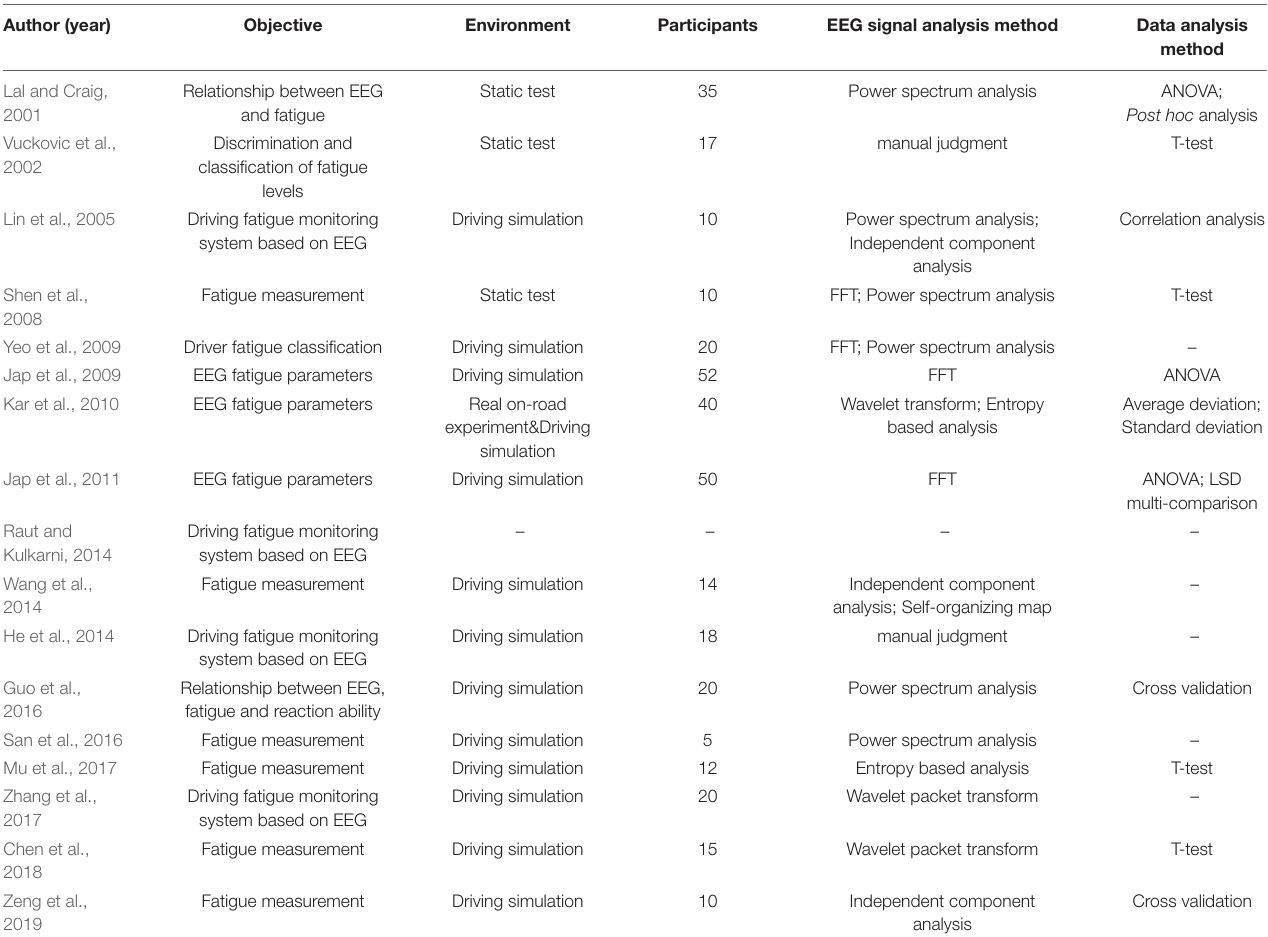
TABLE 1 | Research summary of fatigue driving based on